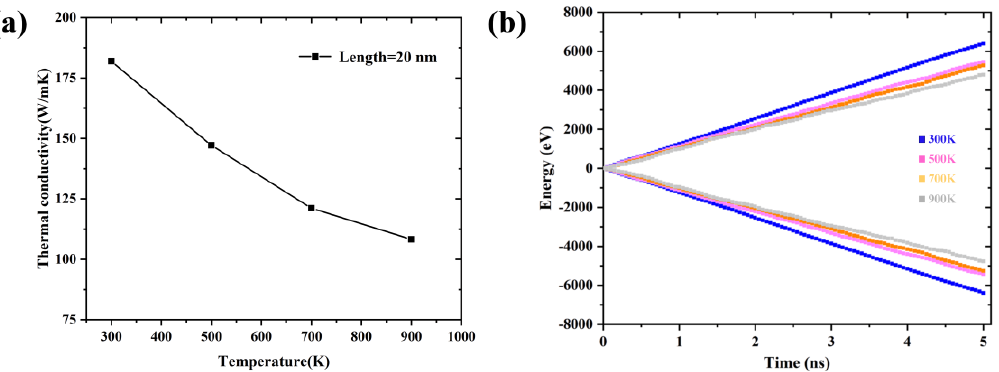
Figure 12. ( a ) The TCs of Gr; and ( b ) the energies added to the hot bath and removed from the cold bath during the NEMD at different temperature.